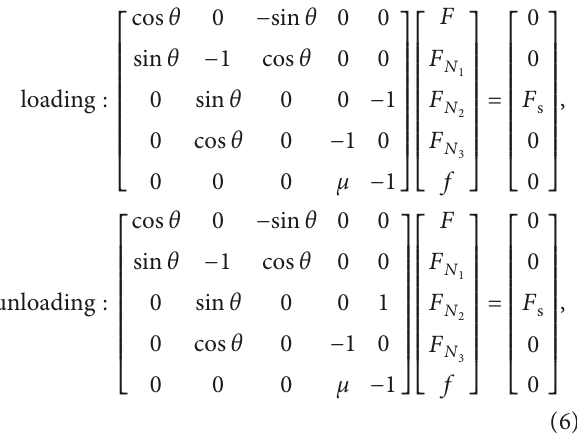
Figure 3: Draft gear characteristic curve under static